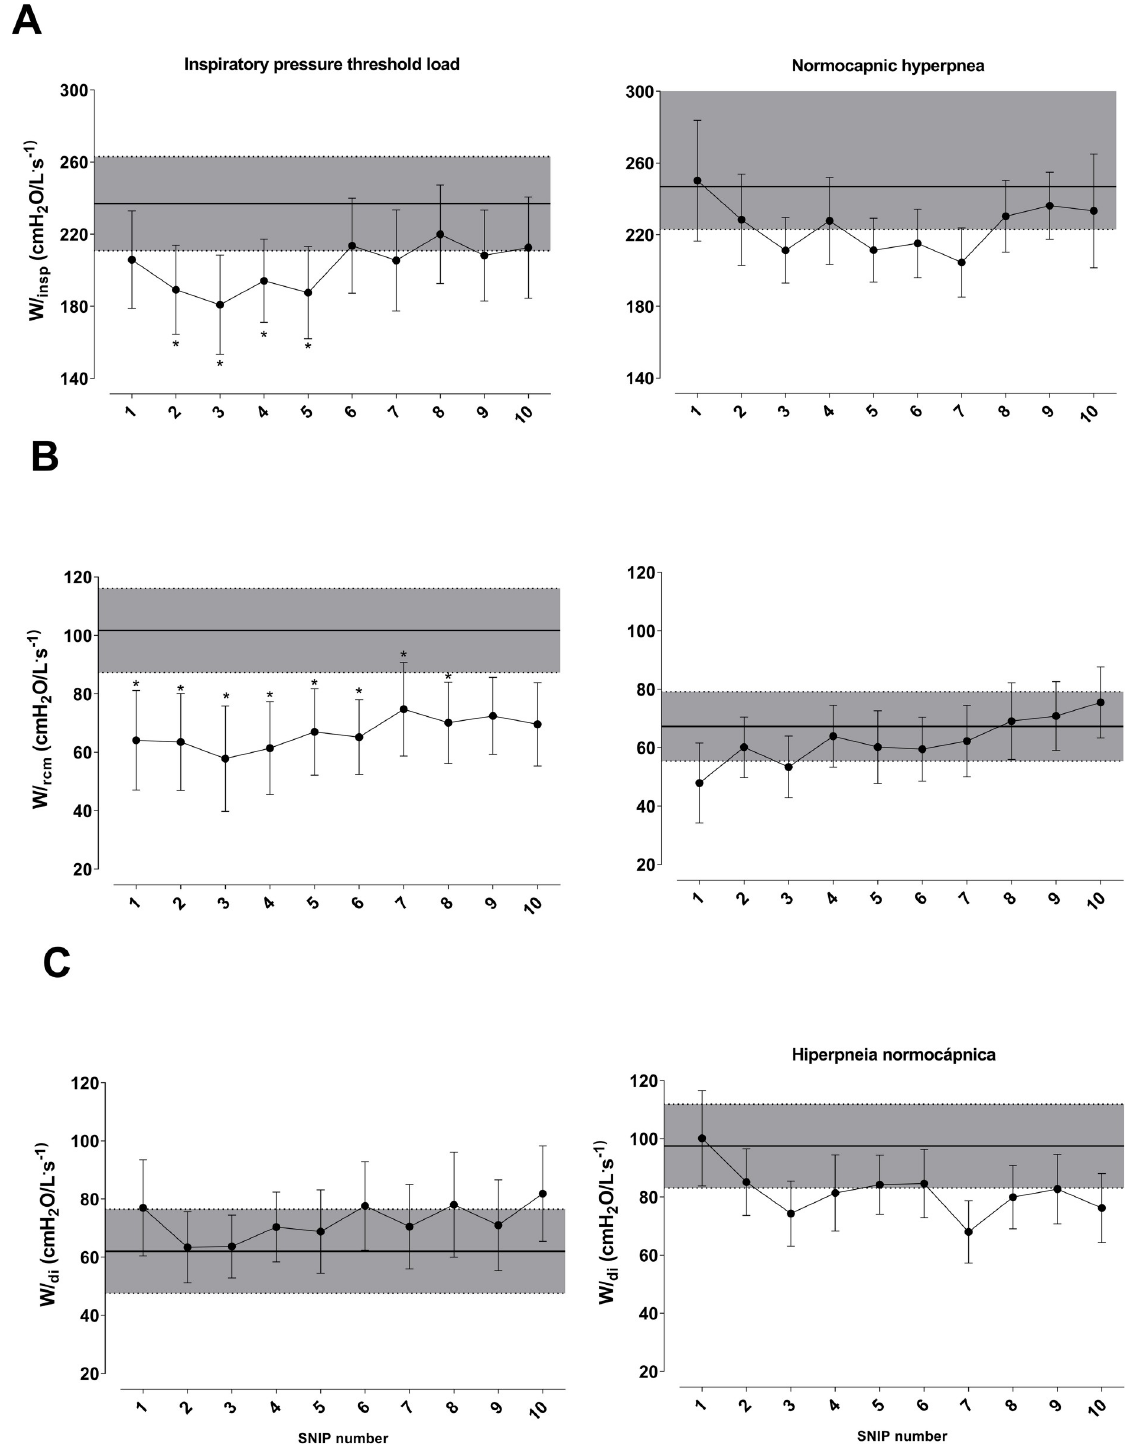
Fig 7. Changes in mechanical power of global inspiratory muscles (Winsp − panel A), inspiratory rib cage muscles (W rcm − panel B), and diaphragm (Wdi − panel C). Comparison of values during recovery of endurance test and pre-test (gray band). Data presented as mean ± SE. Abbreviations: cmH 2 O: centimeters of water; L.s: liters per second. � Statistically significant intragroup difference between pre-test and recovery. p < 0.05.